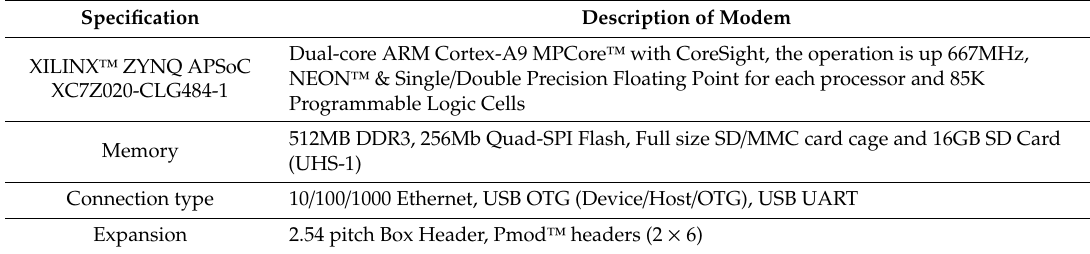
Figure 13 . Multi-media and multi-band modem setup and operations. Figure 13. Multi-media and multi-band modem setup and operations. Table 5. Multi-media / multi-band modem Table 5 . Multi-media/multi-band modem specification.